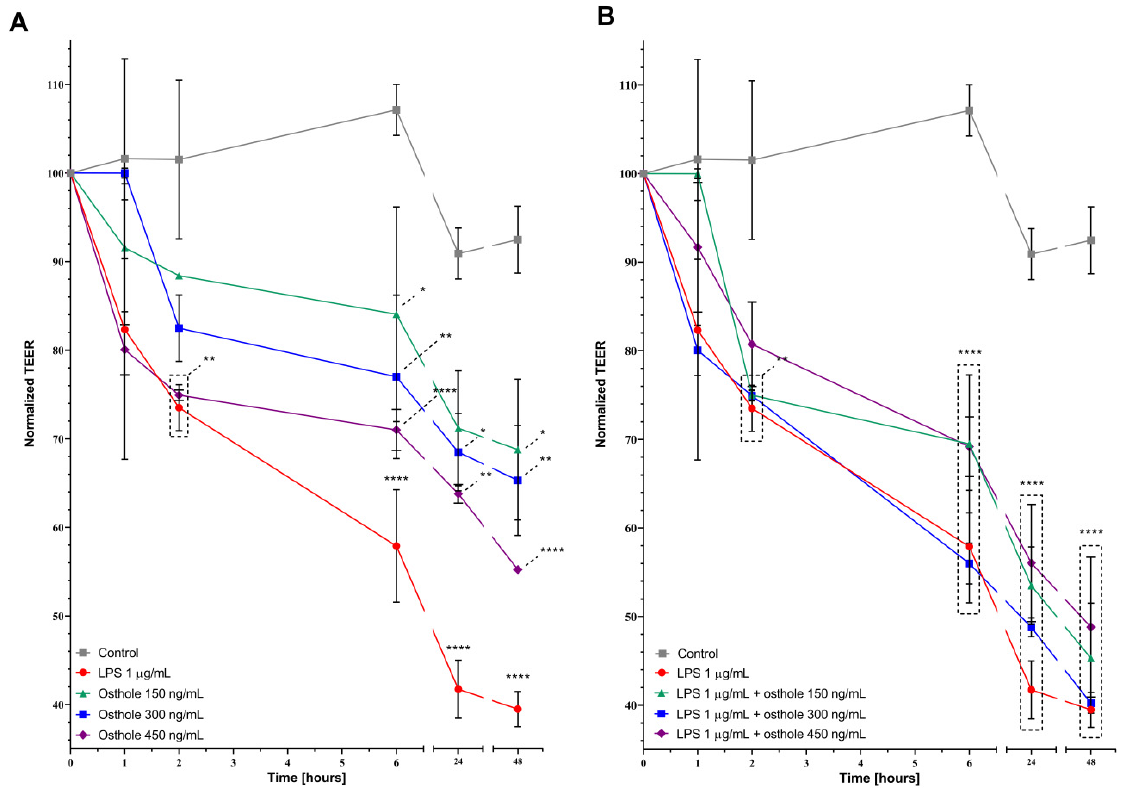
Figure 6. Effects of LPS, osthole ( A ) and its mixtures ( B ) on transepithelial electrical resistance in Caco-2 monolayer). Horizontal line shows mean and bars depict standard error of mean. Statistically significant differences in comparison to control are marked (*— p < 0.05, **— p < 0.01, ****— p < 0.0001).